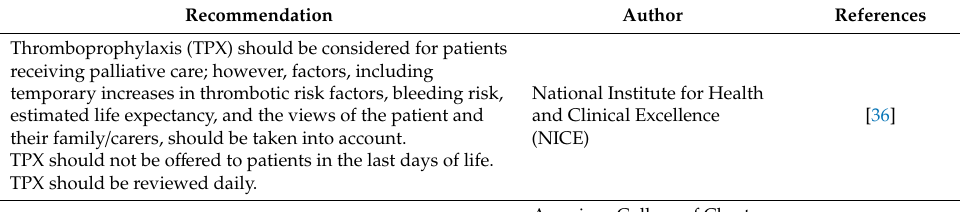
Table 2. Summary of guidelines for thromboprophylaxis in the palliative care